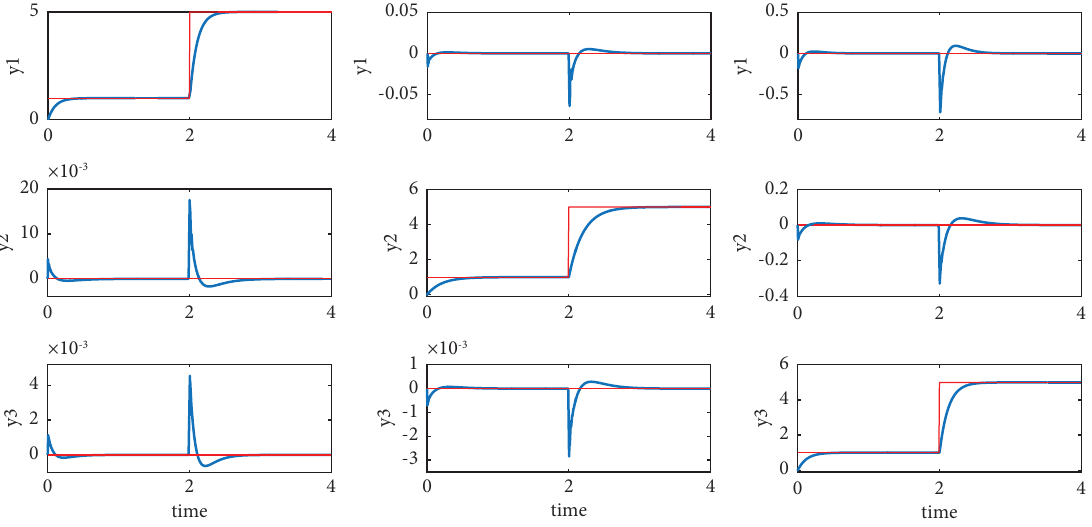
Figure 11: System step response in the second mode.